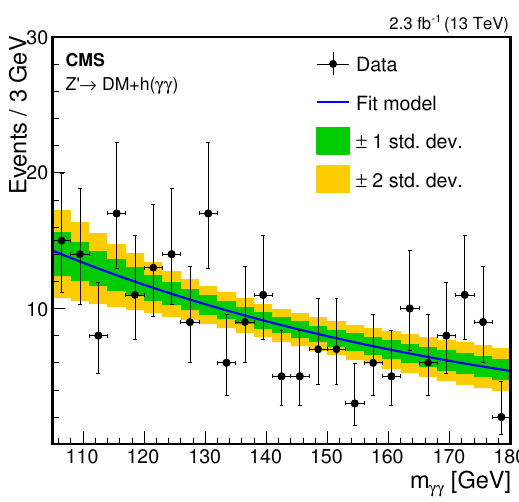
Figure 8 . Fit to the diphoton invariant mass distribution in the low- p miss evaluate (cid:11) . The function used is a power law with one free parameter. The uncertainties in the background shapes associated with the statistical uncertainties of the (cid:12)t are shown by the one and two standard deviation